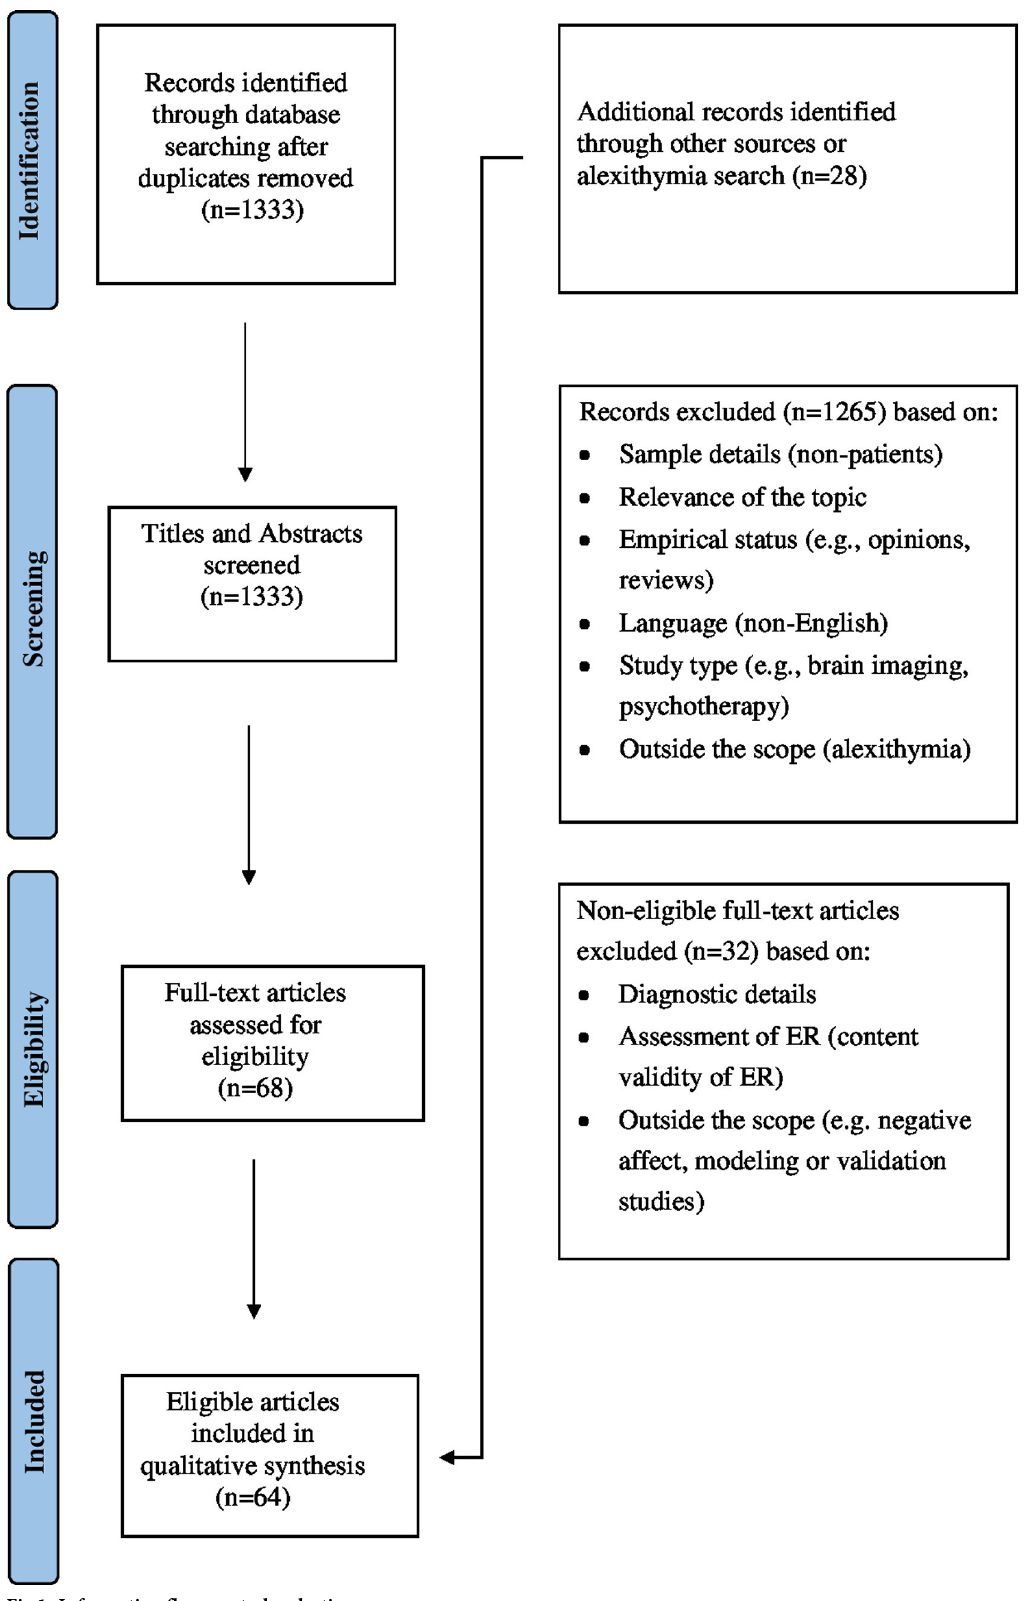
Fig 1. Information flow on study